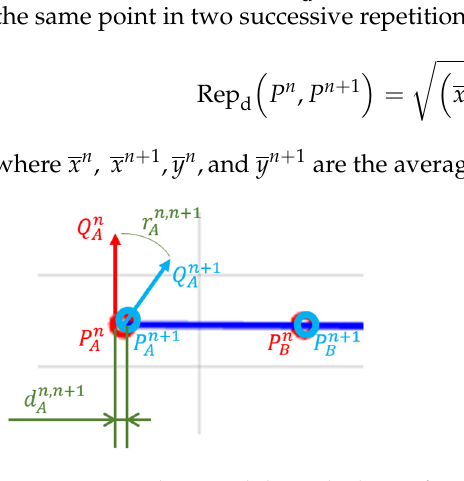
Figure 5. Spatial repeatability calculation for distances and orientation. The red and blue circles represent the stops of the robot tool in two different repetitions and during the trajectory shown in the image as the blue line.